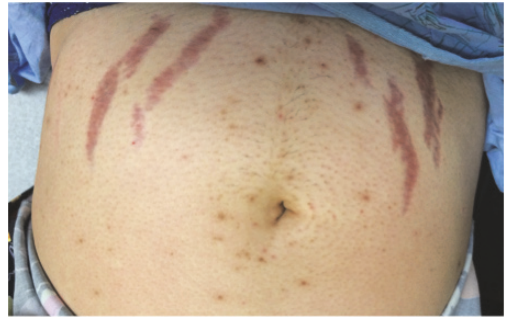
Figure 1: Abdominal striae.